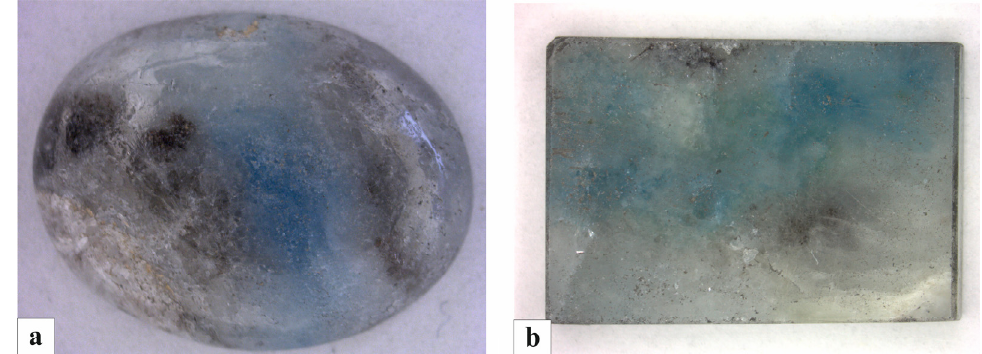
Figure 6. Fashioned gems with blue diopside (samples from the right side of the Sissone.valley): ( a ) sample 9: cabochon cut, oval shape, dimensions 18 mm × 15 mm × 4 mm (photo by E. Borghi); ( b ) sample 6: fantasy cut rectangular shape, dimensions 15 mm × 10 mm × 2 mm.